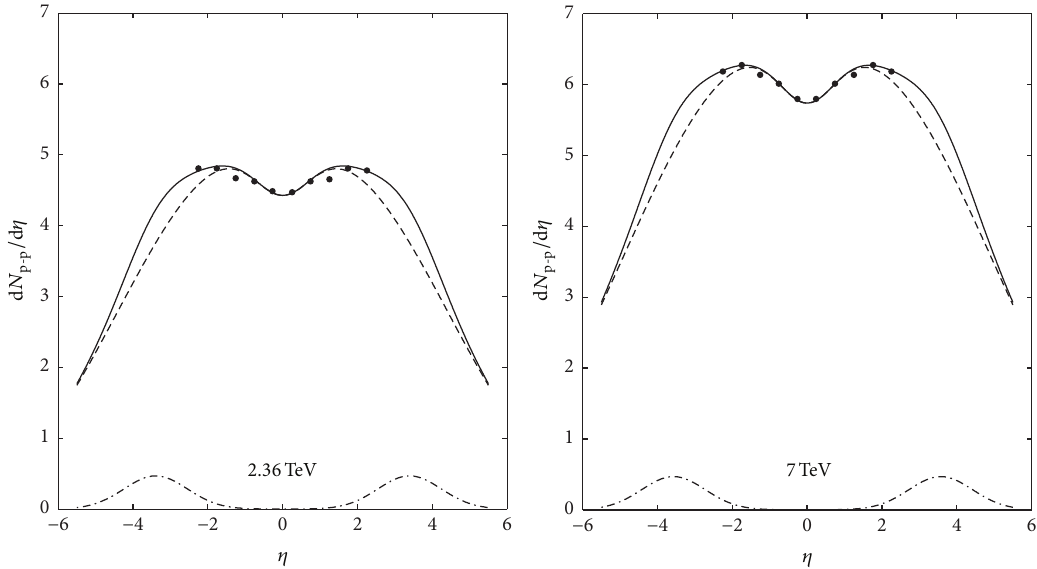
Figure 6: The pseudorapidity distributions of produced charged particles in p-p collisions at energies of √𝑠 = 2.36 and 7TeV. The solid dots are the experimental measurements [41]. The dashed curves are the predicted results from unified hydrodynamics of (19). The dashed-dotted curves are the predicted results from leading particles of (20). The solid curves are the sums of dashed and dashed-dotted